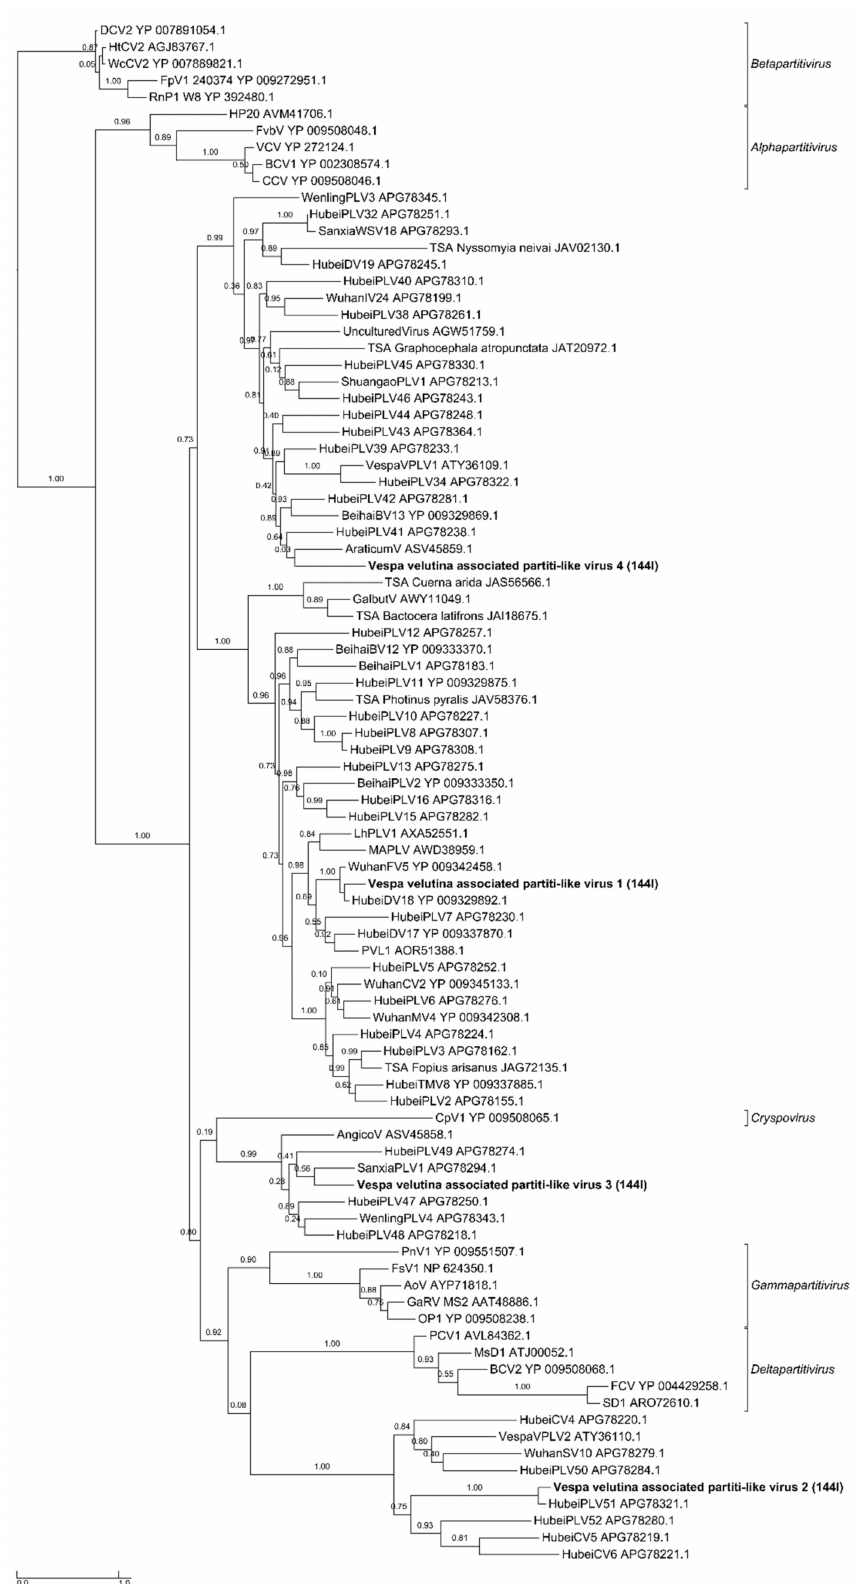
Figure 7. Maximum likelihood amino acid replicase phylogeny of Vespa velutina associated partiti-like viruses 1–4 (384 aa, LG + I + G + F model). GenBank accessions are in Table